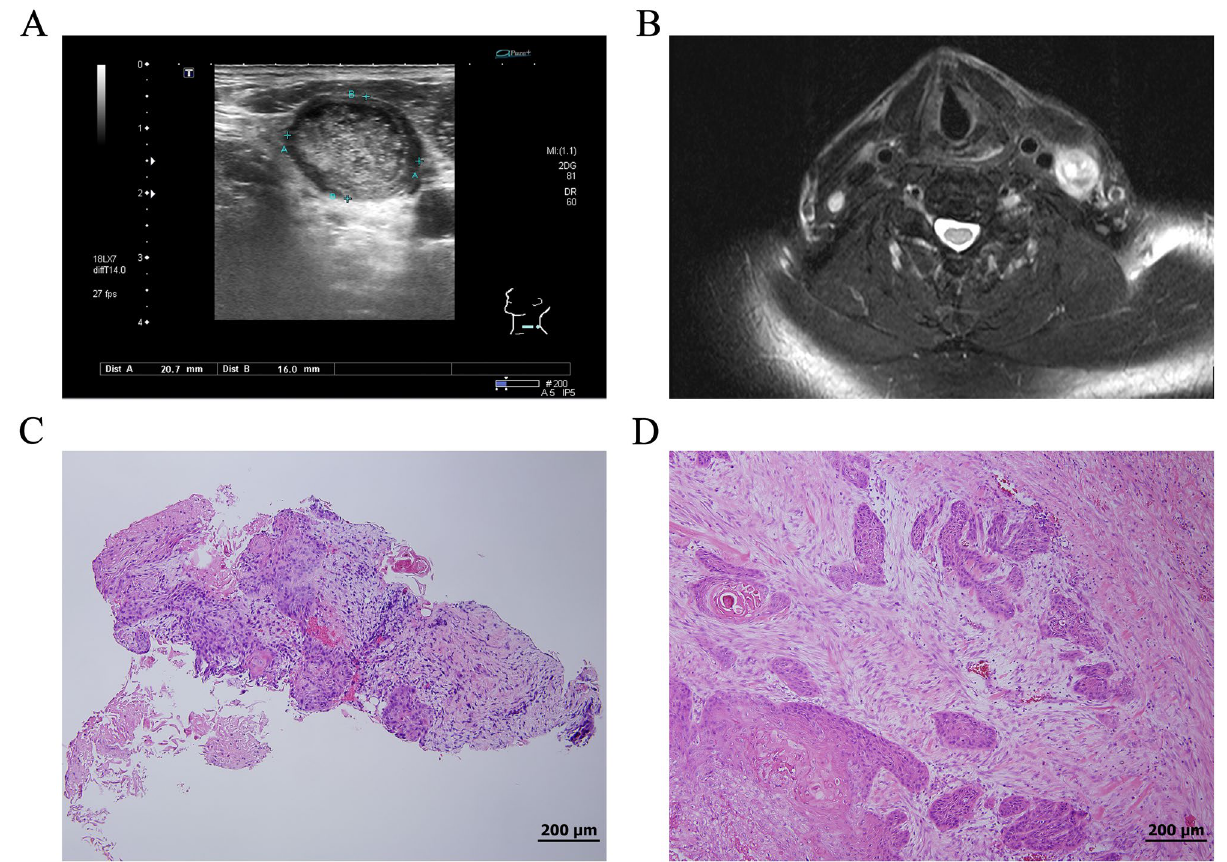
biopsy (CNB) revealed necrotic tissue with metastatic squamous cell carcinoma (SCC) in nests infiltrated in the fibrotic stroma; and ( D ) tissue from salvage neck dissection revealed metastatic SCC without extranodal